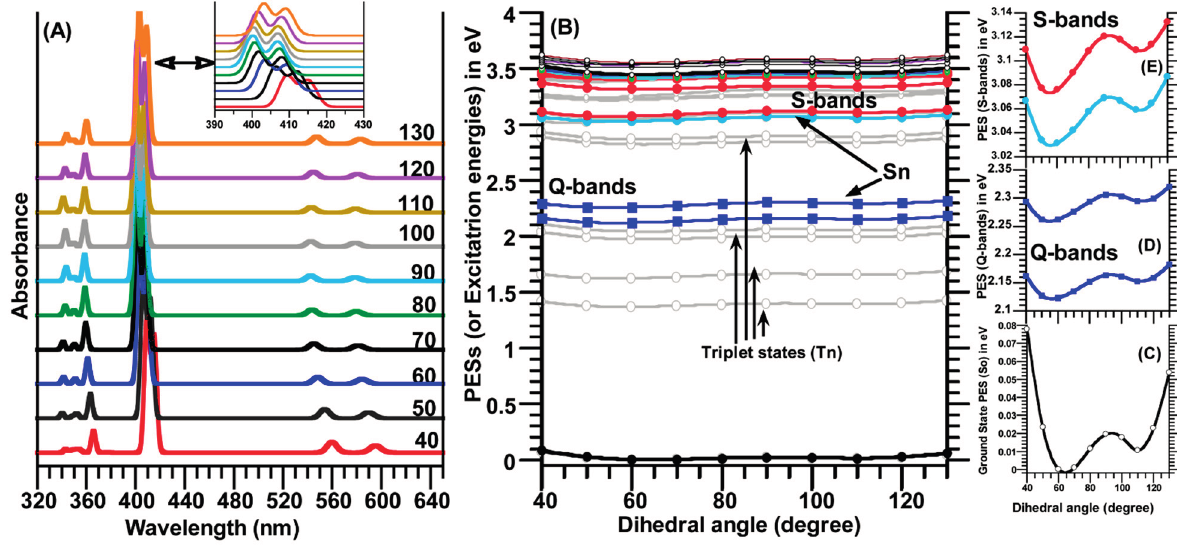
Figure 7. ( A ) The calculated electronic spectra (S 0 → S n , n = 1–24) and ( B ) relaxed potential energy surfaces (PESs) scan for the ground state S 0 and upper states S n and T n ( n = 1–24) of the TSPP molecule as function of the dihedral angle (C α -C m -C ϕ -C(ph)) rotation in the range of 40° to 130° with a step size of 10°; ( C – E ) display the change in the PES for the S 0 (the ground state), Soret bands (B-bands) and Q-bands in low scale for a better view. It should be noted that only one of the four meso-sulfonatophenyl groups rotated around C m -C ϕ bond. Note that the S-bands in Figure 7E indicates the Soret bands (or